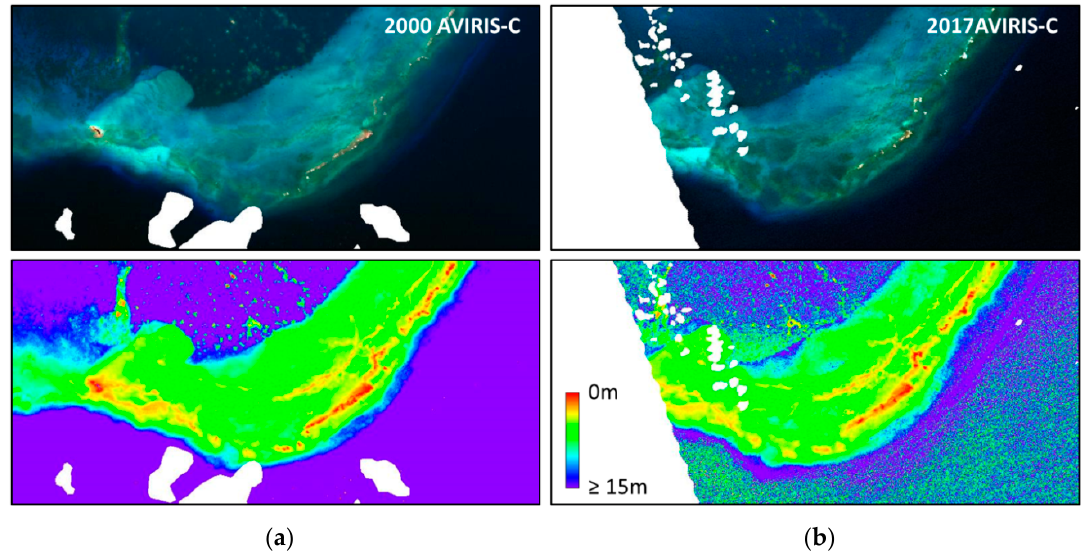
Figure 6. Derived bathymetry for 2000 and 2017 French Frigate Shoals data at 18 m spatial resolution, illustrating the need for an automated methodology to subset shallow reef areas from deeper offshore water: ( a ) 2000 true-color image and derived water depth; ( b ) 2017 true-color image and derived water depth. Areas with no data and masked areas of land, cloud, cloud shadow, and wave breaks are shown in white.